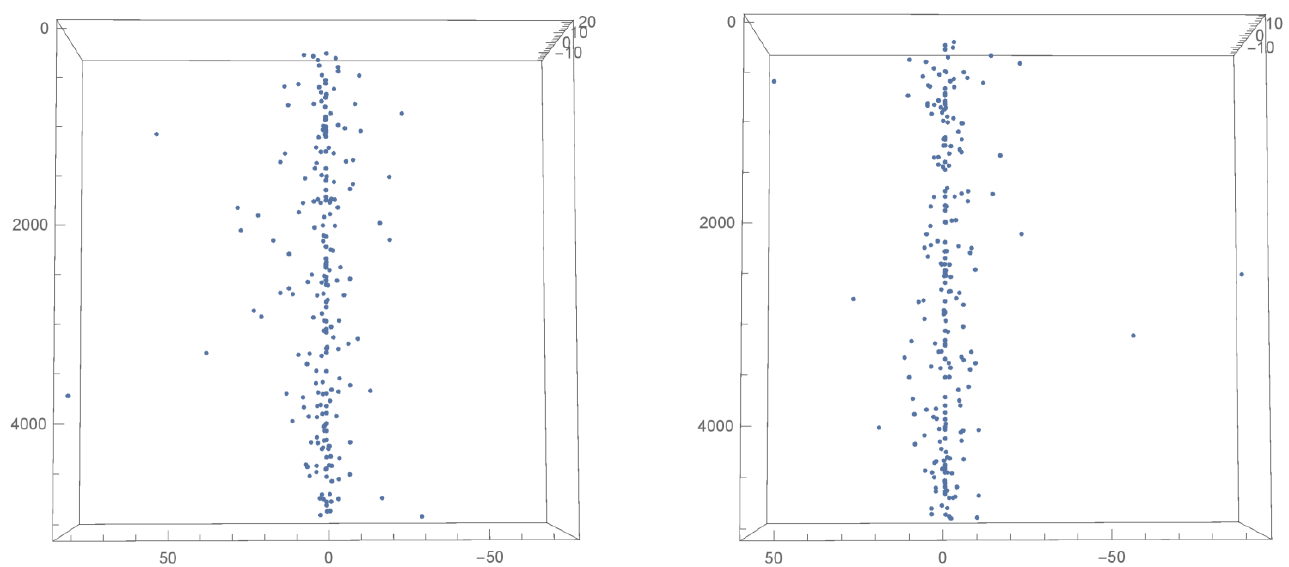
Figure 3. Typical 3D snapshots of ionization tracks induced directly by one 1-MeV p + in amorphous water ice calculated with the RITRACKS computer code [2,3]: spatial distributions of ionizations in two randomly selected proton impact events. Top is the sample surface. The proton beam axis is perpendicular to the sample surface plane. The left and right scales correspond to the depth and thickness in Å units.